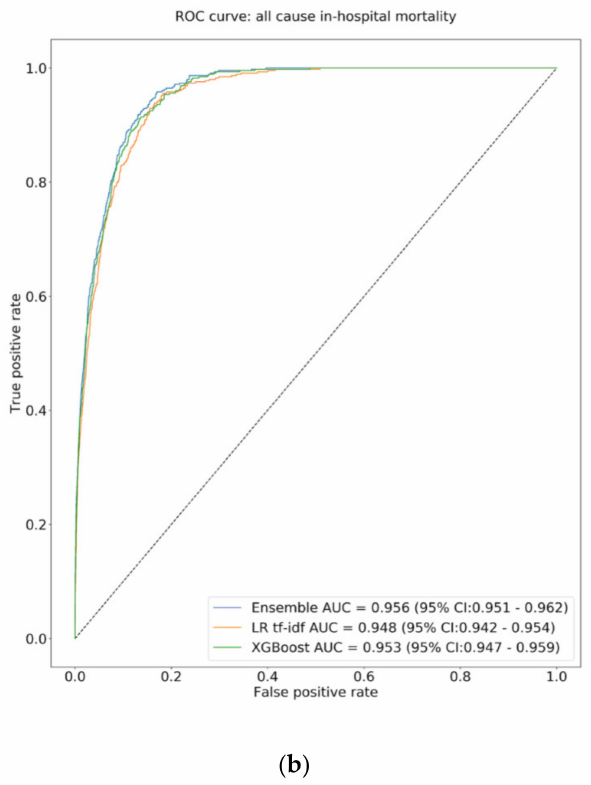
Figure 4. ( a ) Receiver operator curves (ROC) for predicting 48-h mortality ( b ) ROC for predicting overall in-hospital mortality.